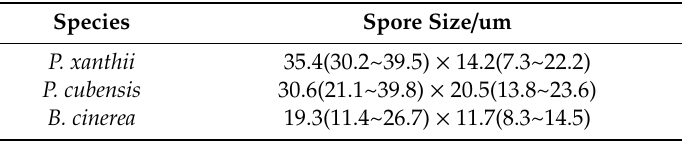
Table 1. Spore sizes of the airborne diseases from the three greenhouse crops.